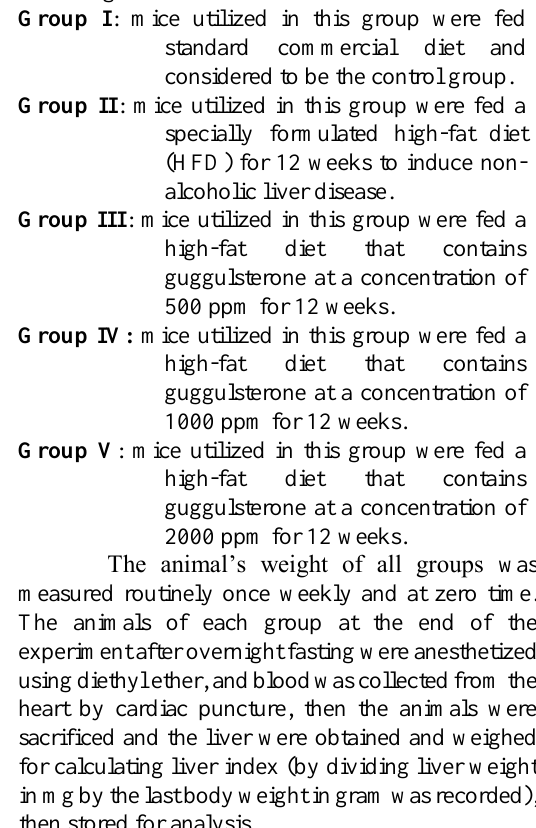
Figure( 1) Effects of guggulsterone on the liver index of mice models with high-fat diet induced NAFLD, * is a significantly different compared to the control group (P<0.05). # is significantly different compared to the HFD group